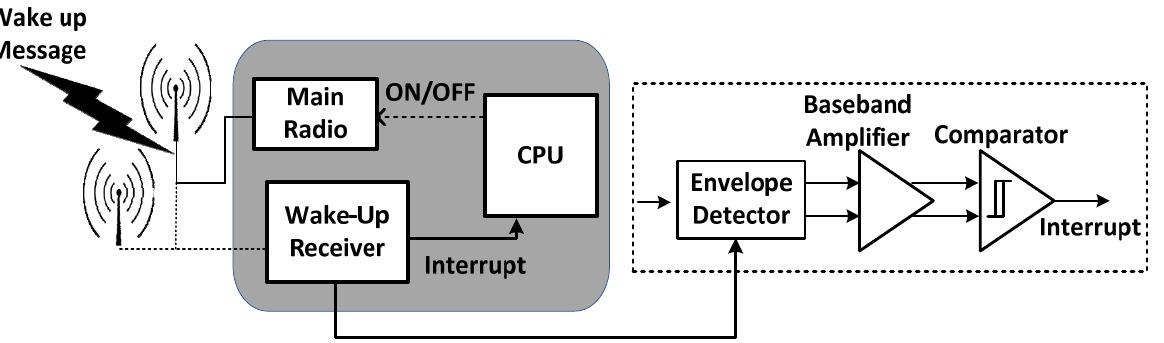
Figure 1. Typical block diagram of a wireless part of IoT sensor node with a separate wake-up receiver.